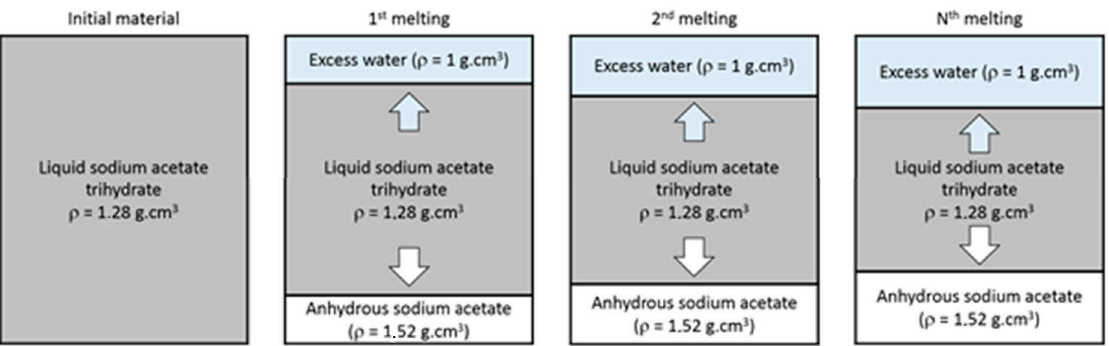
Figure 7. Schematic diagram of SAT aging throughout melting cycles.